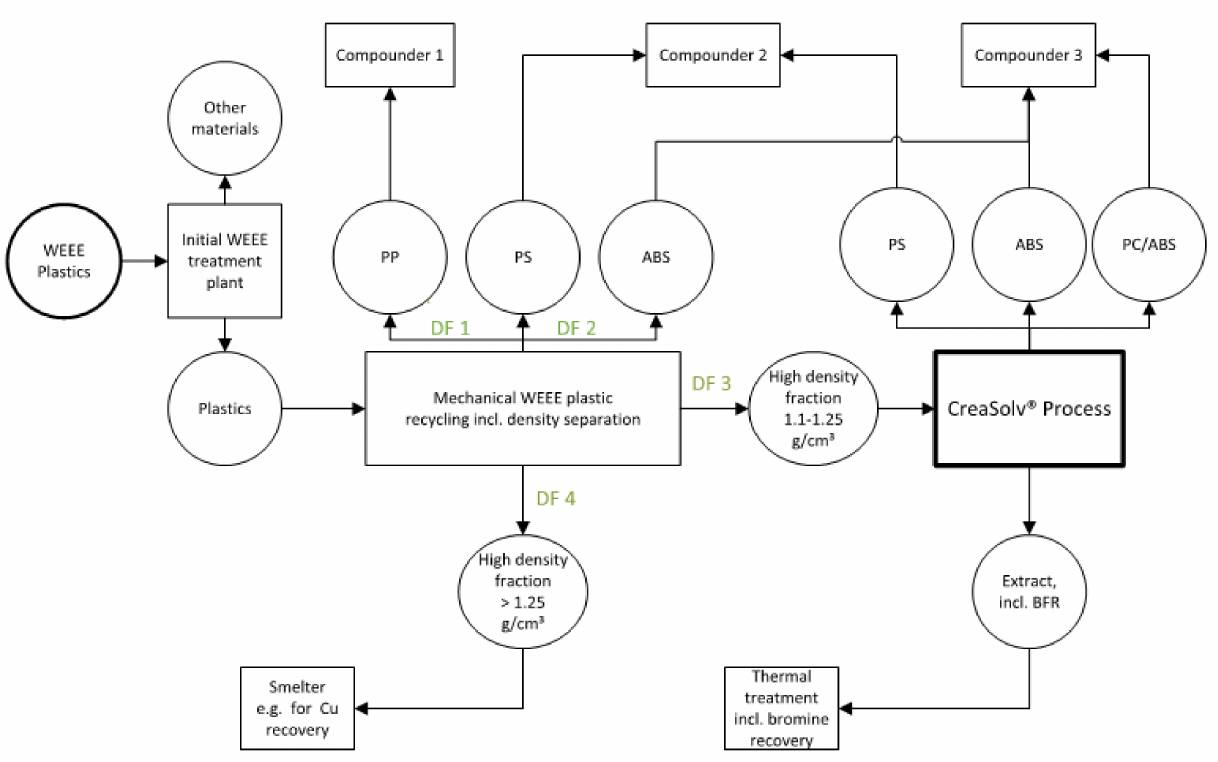
Figure 4. Recycling concept for WEEE plastics combining density separation with CreaSolv ®